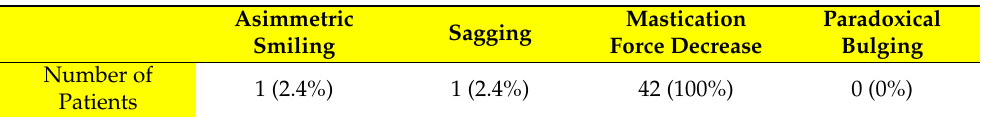
Table 1. Incidence and percentage of complications related to BonTA injection according to biphasic technique performed on patients presenting MMH.